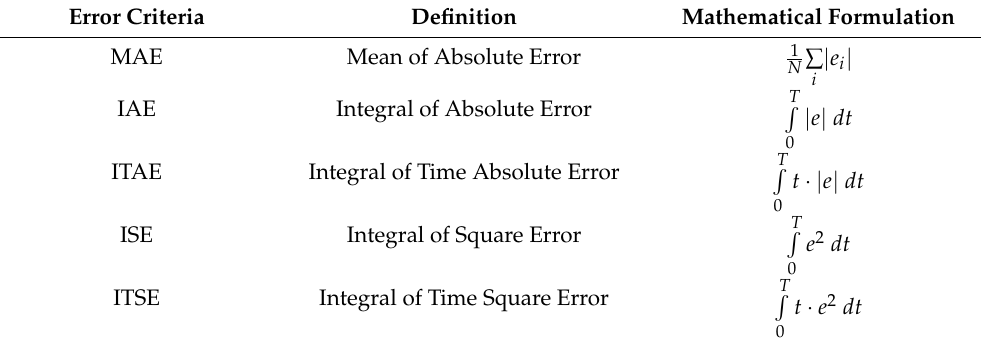
Table 1. Error Table 1. Error criteria.